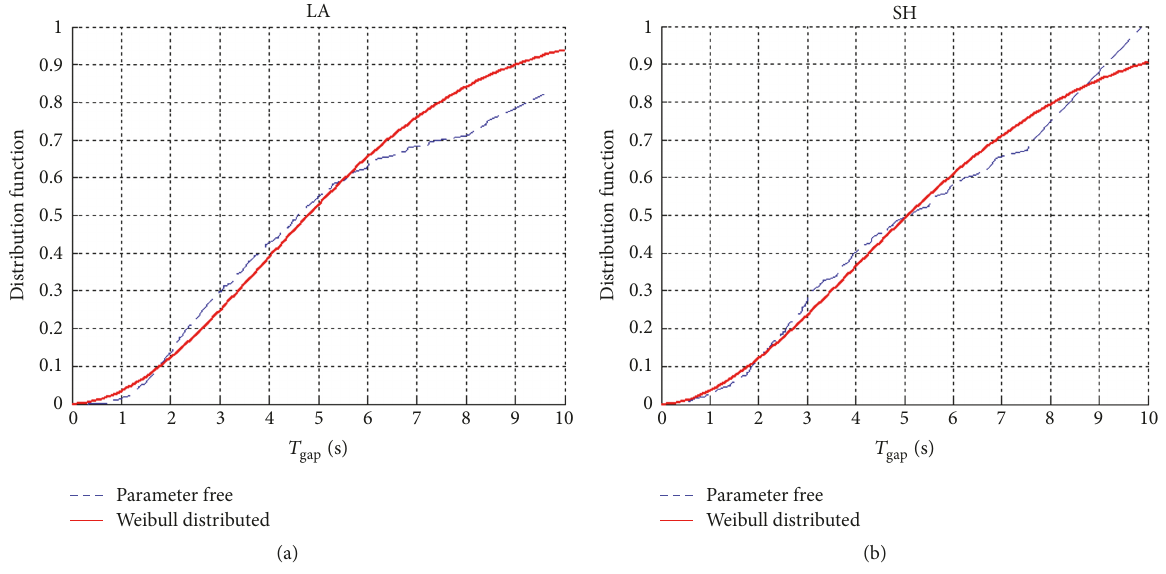
Figure 9: Weibull distribution function (the data used here are the samples of All ).